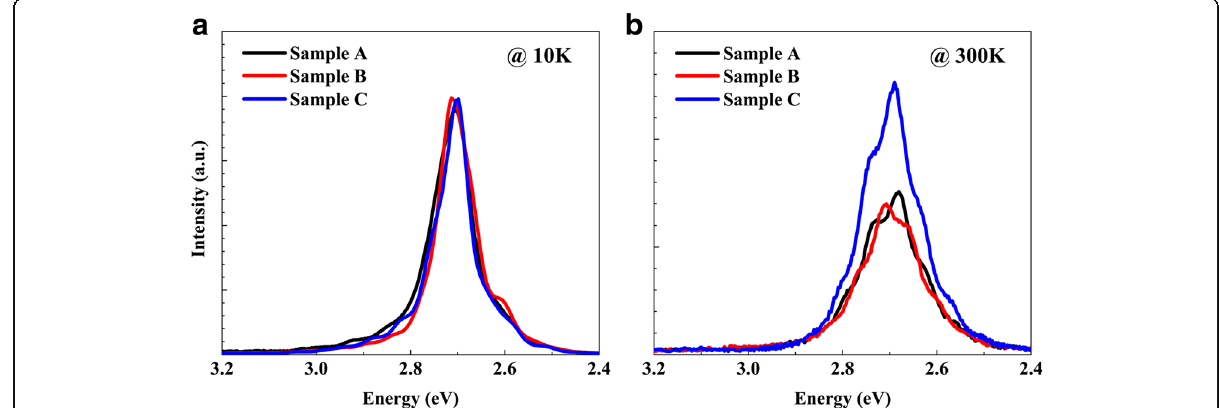
Fig. 2 The measured PL spectra a at 10 K, and b at 300 K of all the